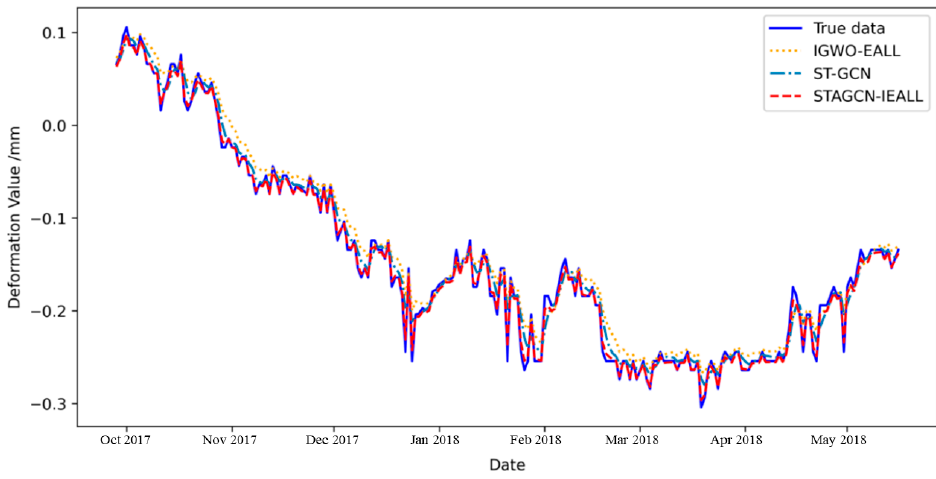
Figure 12. Comparison of prediction e ff